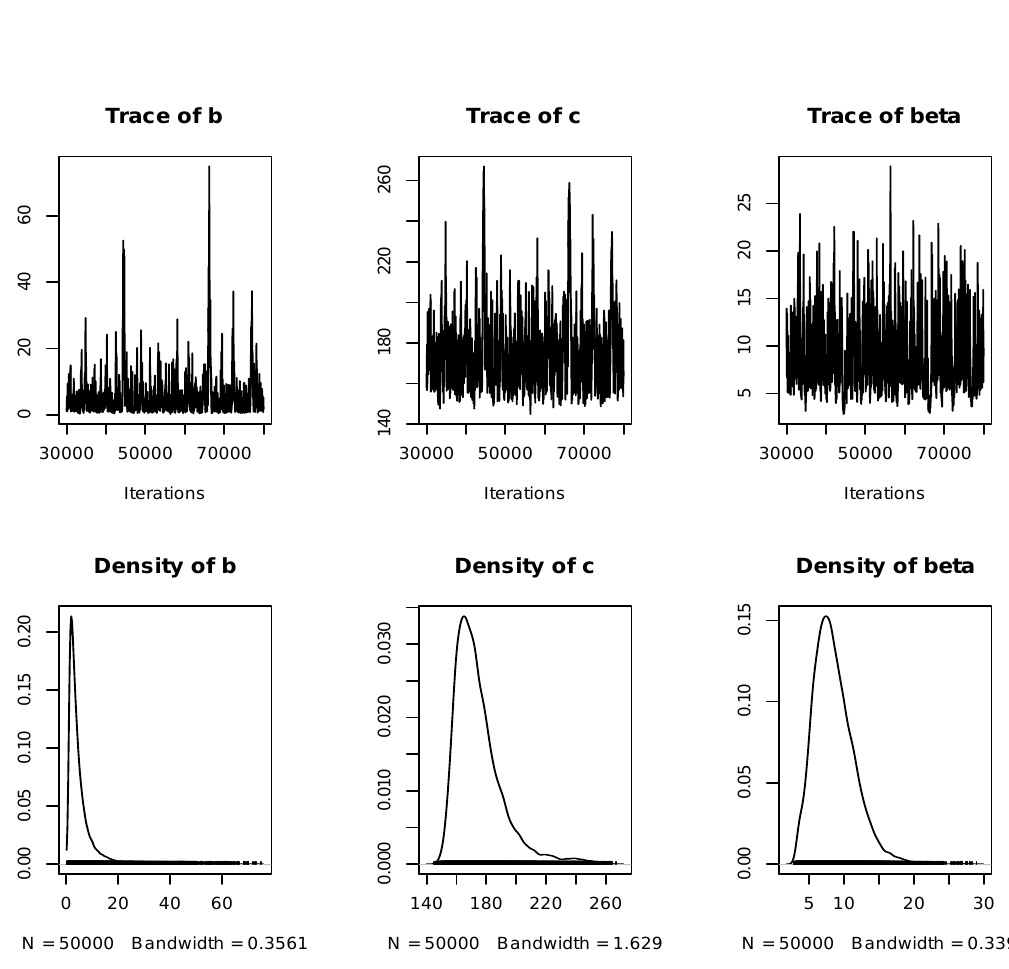
Fig. 4. Trace plots of simulated parameter values of the Kumaraswamy inverse Weibull distribution.